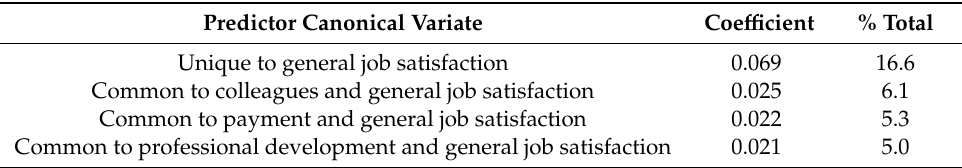
Figure 1. Graphic display of structure correlations (loadings) of the Kurzfragebogen zur Erfassung von Allgemeiner und Facettenspezifischer Arbeitszufriedenheit (KAFA) scales on the first predictor canonical variate and of the structure correlations (loadings) of the Maslach burnout inventory (MBI) scales on the first criterion canonical variate. Black bars correspond to positive correlations and white bars correspond to negative correlations. Table 3. Main results of commonality analysis for the first prediction canonical